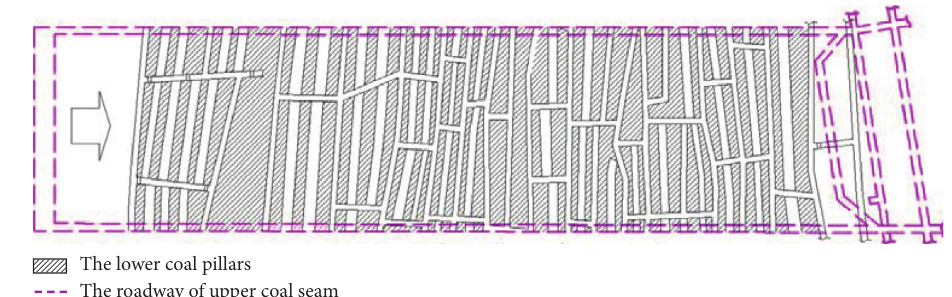
Figure 3: Mining engineering plan schematic